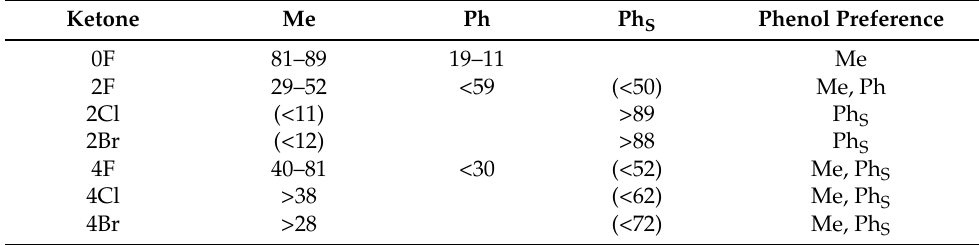
Table 1. Estimated fractions of methyl docking (Me), phenyl docking (Ph), and phenyl docking with dominant stacking (Ph S , low IR visibility if stacking competes with the hydrogen bond) for the phenol complexes of halogenated acetophenones in % of the total composition. Numbers in parentheses are generous estimates without unambiguous absorption feature, based on the signal size which the noise level may still